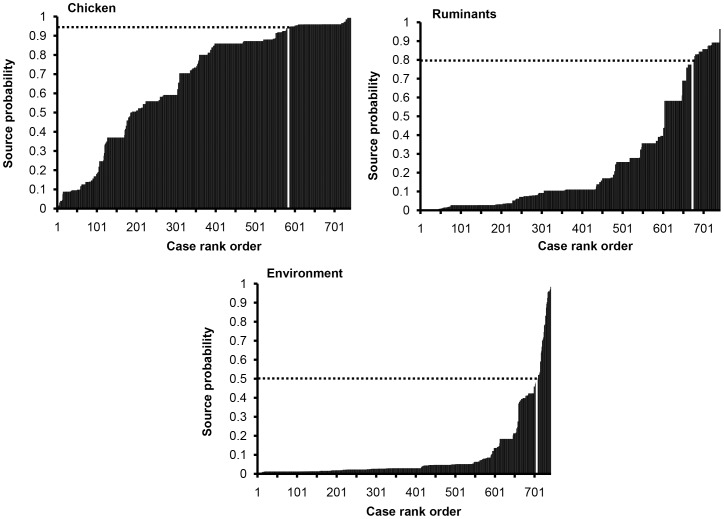
Rank ordered assignment source probability per human case (vertical columns).The white vertical columns indicate the cut-off points beyond which cases were selected for inclusion in the risk factor analysis. Cases are in ascending order according to the source probability to aid visualization.